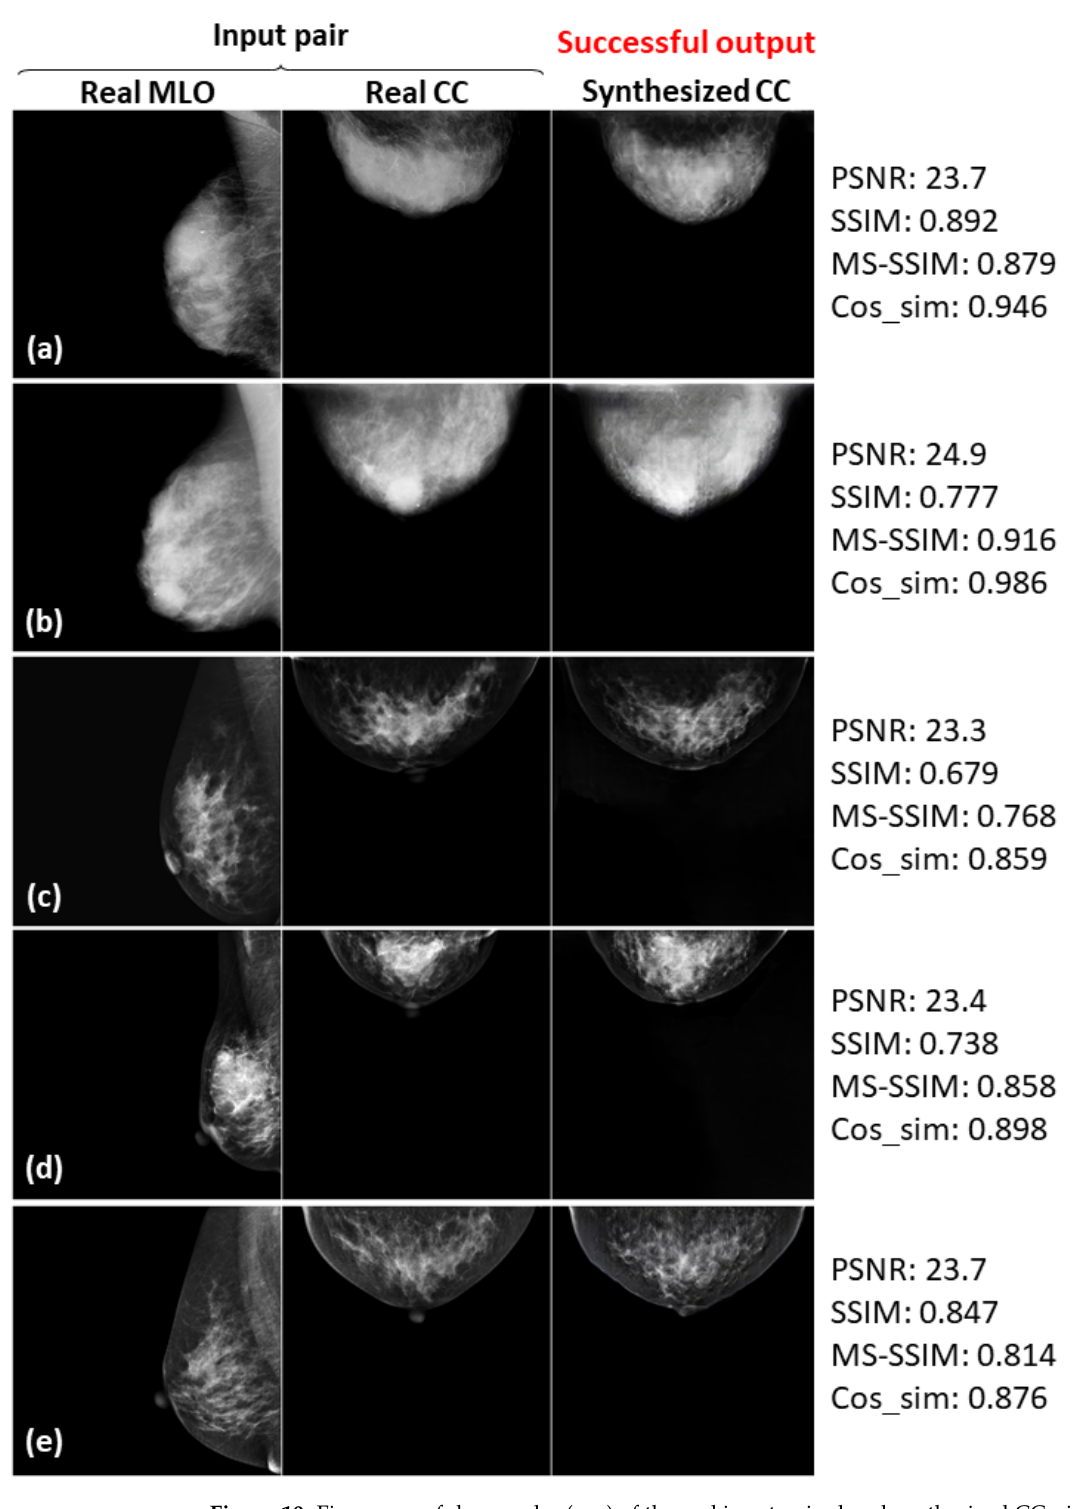
Figure 10. Five successful examples ( a – e ) of the real input paired and synthesized CC-view mammo- grams at 512 × 512 resolution by bi-directional training of CR-GAN incorporating PG technique and feature matching